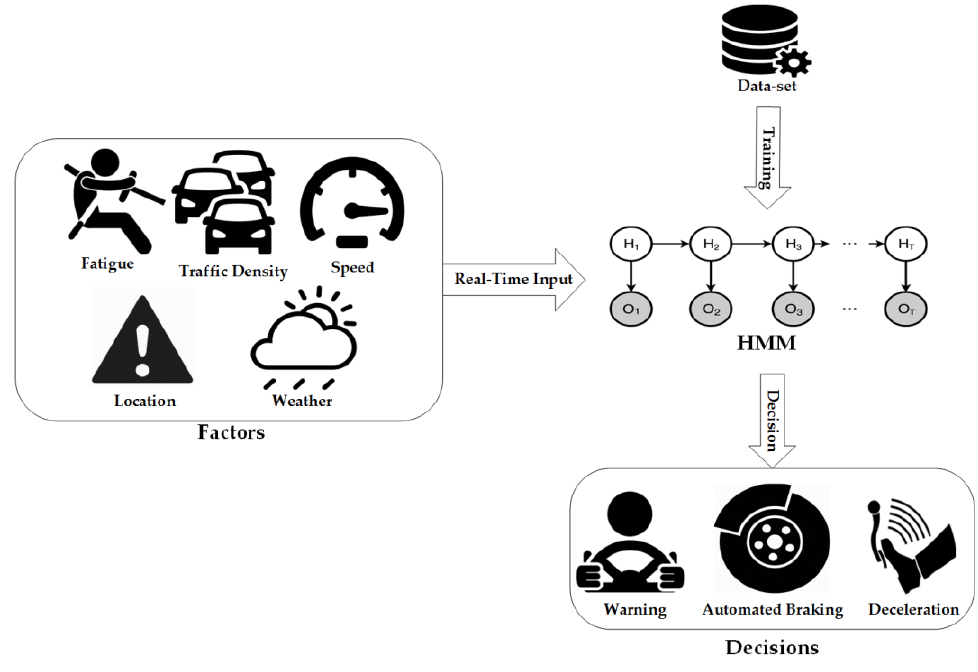
Figure 1. The proposed system.